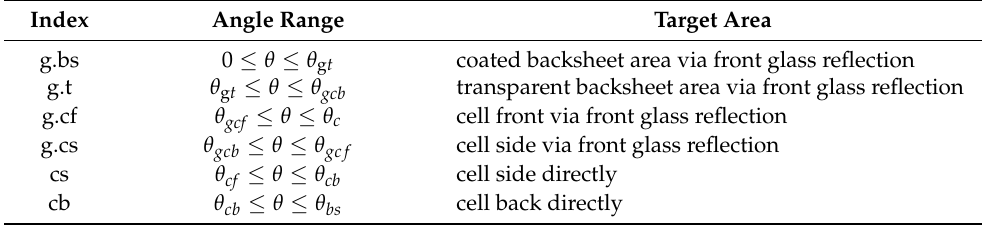
Table 1. Definition of ray groups by reflectance angle and surface that is hit by the rays in this group.